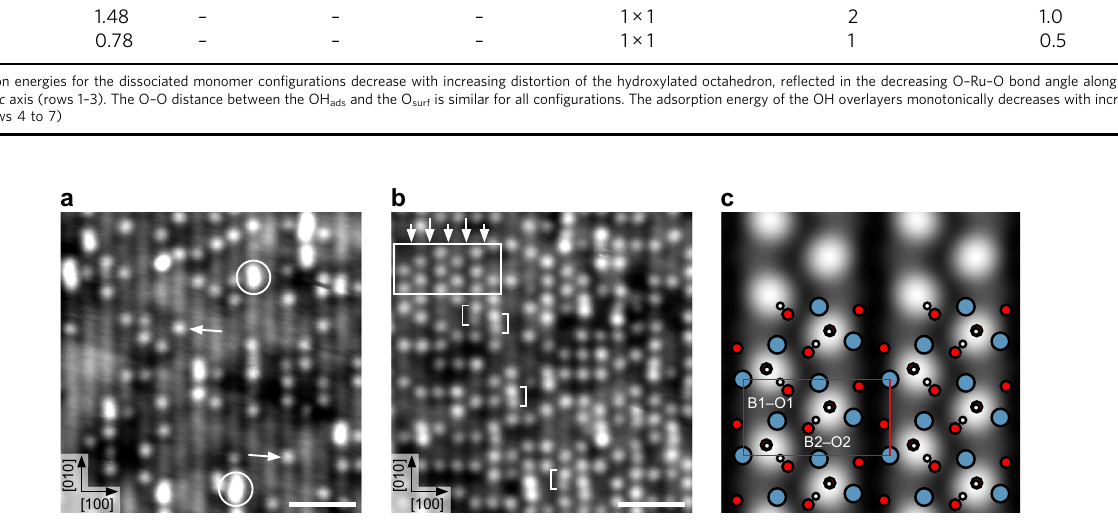
Fig. 4 Water adsorbed on cleaved Ca 3 Ru 2 O 7 and the (2 × 1) OH overlayer. a STM image of 0.3 Langmuir water dosed at 105 K. Single, bright features ( arrows , 0.13 ML) that sit on the bright lines of the substrate are attributed to the (OH) ads of dissociated water. This agrees with the model that predicts the (OH) ads to adsorb on bridge sites B1 or B2, i.e., on the bright lines of the substrate (see Fig. 3). The larger, brighter features ( circles ) contain several H 2 O molecules. b STM image of the sample in panel a after annealing for 1 h at room temperature. The coverage increase from 0.13 to 0.34 ML corroborates that the larger, bright features ( circled in panel a ) contained several H 2 O molecules that became mobile, dispersed across the surface and dissociated. The box marks a more densely covered area with local (2 × 1) symmetry. Double lines are formed, with a smaller gap within the double line, and a wider gap separating two double lines, marked by short and long arrows , respectively. See panel c for model. The brackets mark spots separated by half a unit cell along [010], named bright-dark feature. This feature is tentatively assigned to two (OH) ads on neighboring bridge sites, i.e., B1-O1 and B2-O2, with one of the (OH) ads appearing darker than the other. c DFT model and TH simulation of the (2 × 1) OH overlayer, corresponding to a coverage of 0.5 ML. The single-unit-cell spacing along each line leads to occupation of either the B1O1 or the symmetrically equivalent B2O2 con fi guration (see Fig. 3). In adjacent lines the (OH) ads are shifted by half a unit cell in [010] direction and thus occupy the other con fi guration. Therefore, the (OH) ads on adjacent lines are shifted along [100] in opposite directions, leading to narrow and wide gaps between the lines. STM parameters: T sample = 78 K, V sample = − 0.8 V, I tunnel = 0.1 nA; fast scan direction is 18° clockwise from horizontal. All scale bars correspond to 2